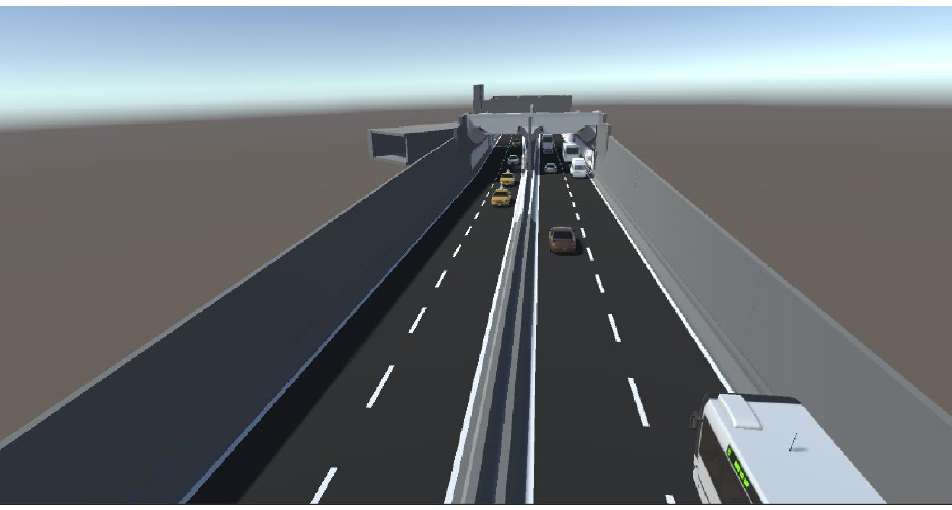
Figure 8. Example of tunnel traffic simulation results.